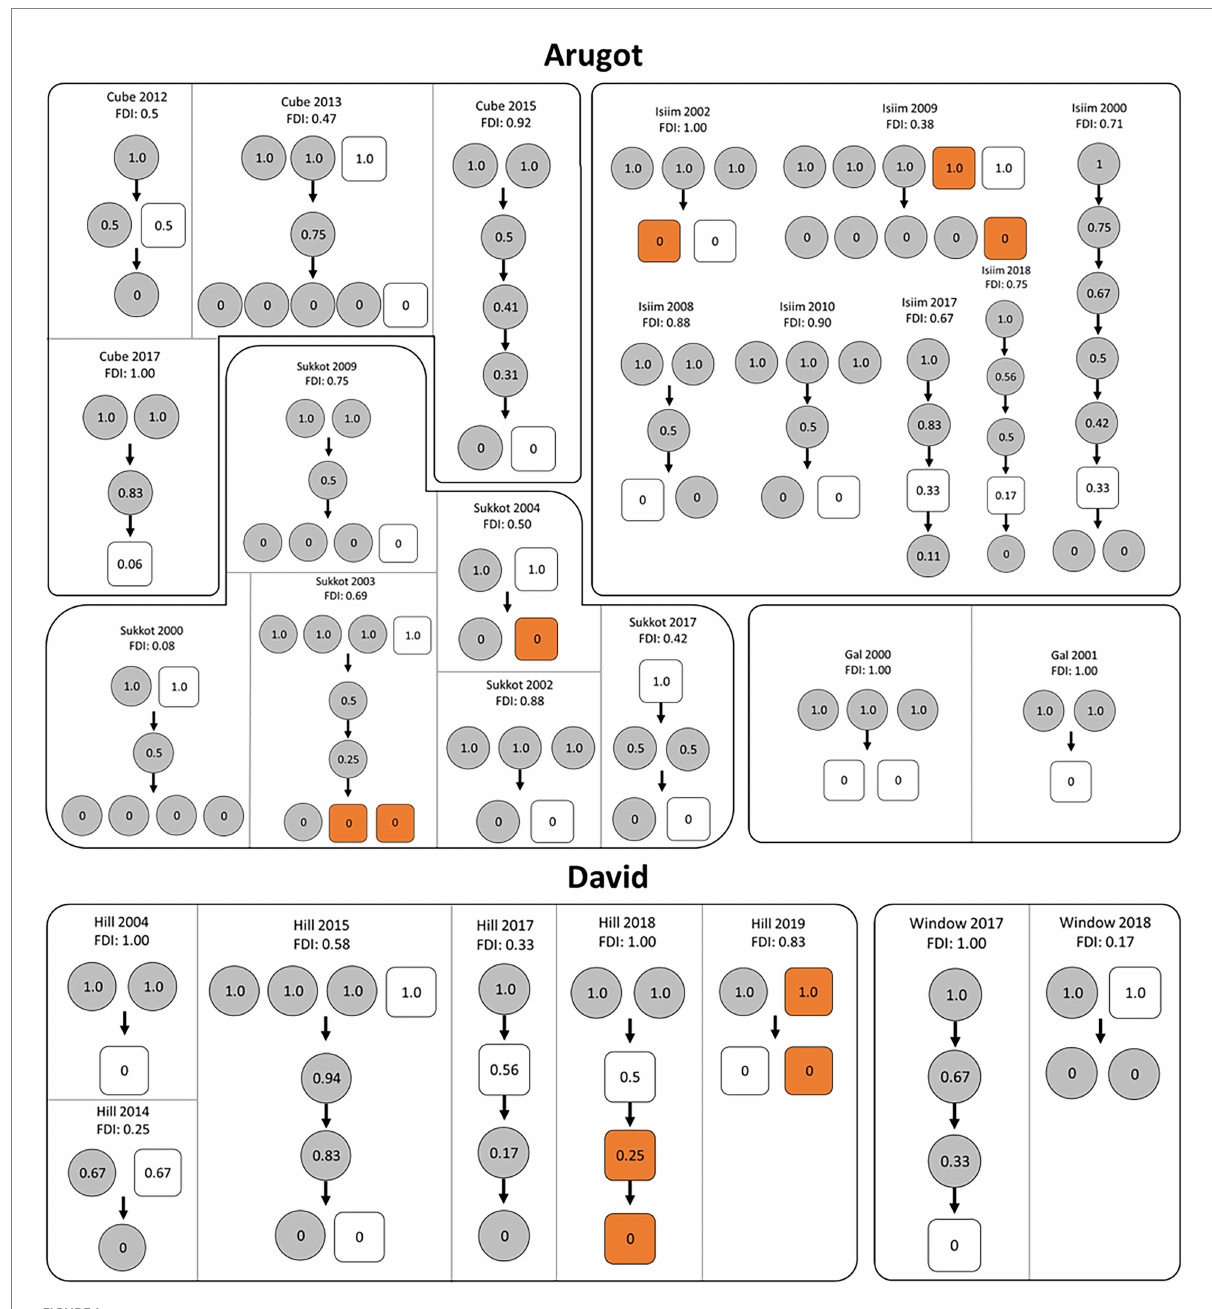
FIGURE 1 Dominance hierarchies in groups of rock hyrax among adults of both sexes per group-year at two sites, Arugot and David in Ein Gedi, Israel. Partitions indicate name of the group and year of study. FDI represents the Female Dominance Index per group-year. Circles represent females and squares represent males. The average dominance index of each individual is shown in the circles and squares. Late dispersers (males) are indicated in